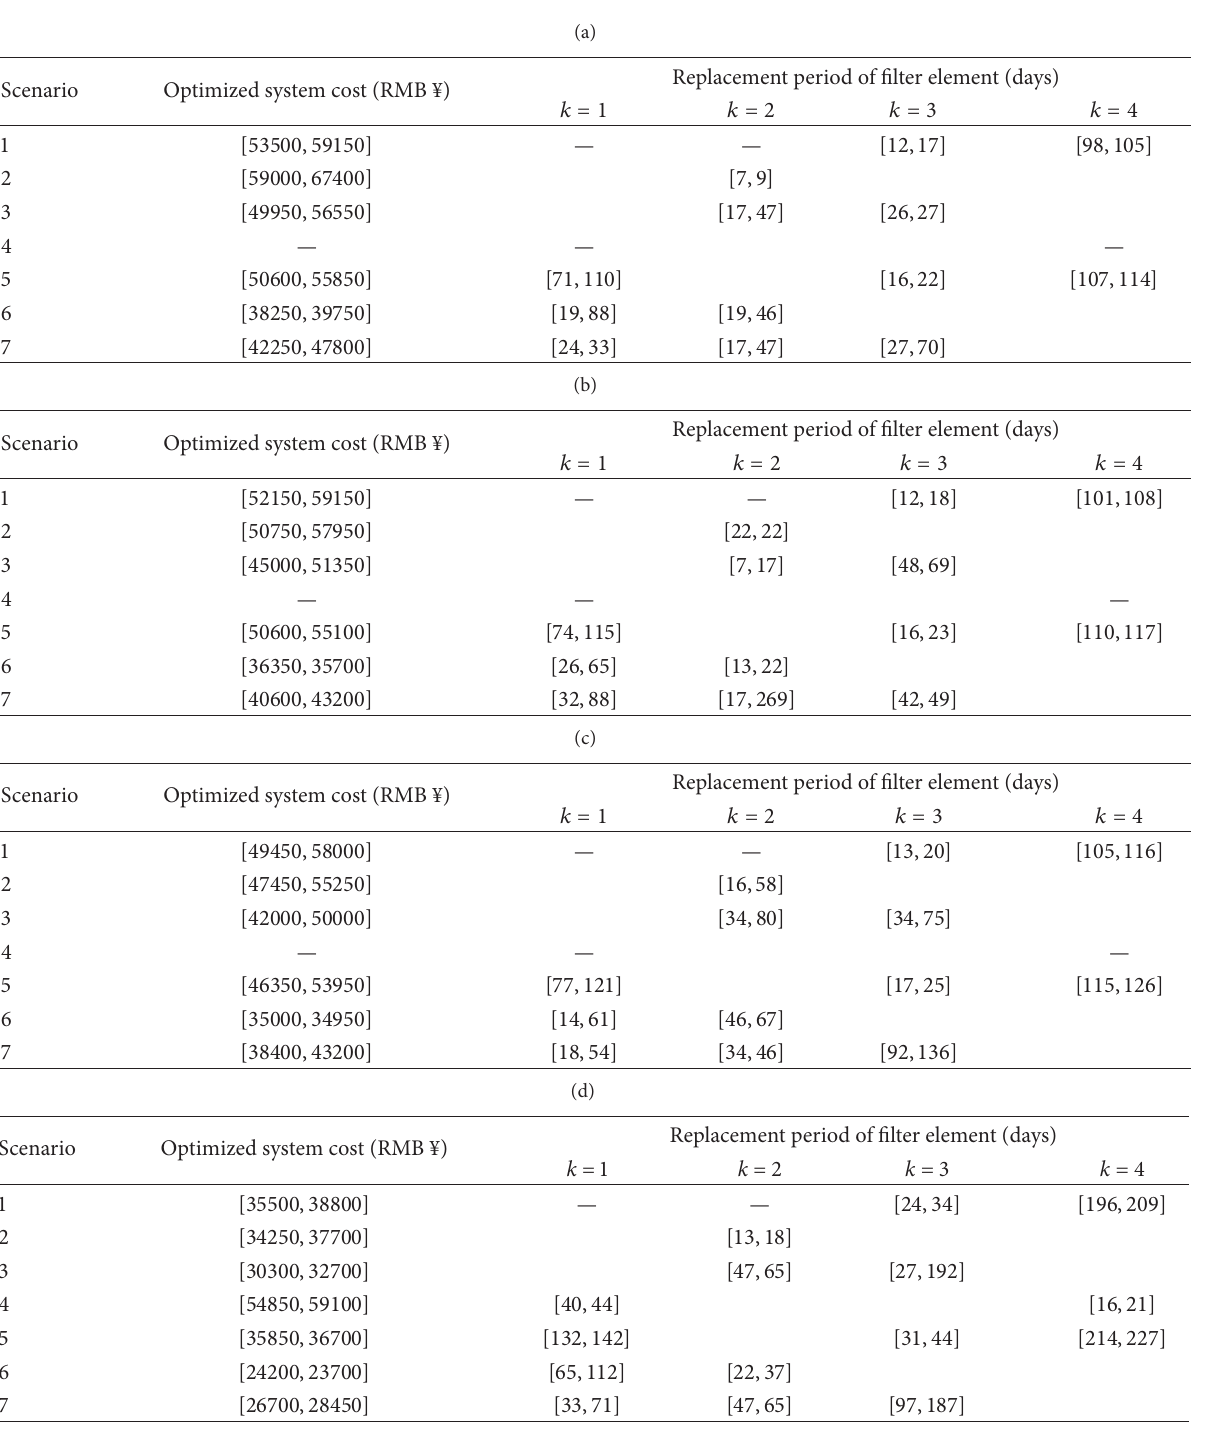
Table 8: (a) Results for optimized system cost and filter-replacement period under high ingression/generation rate (8 hours per day) (when = 0.10 ). (b) Results for optimized system cost and filter-replacement period under high ingression/generation rate (8 hours per day) 𝑝 1 (when 𝑝 2 = 0.15 ). (c) Results for optimized system cost and filter-replacement period under high ingression/generation rate (8 hours per day) (when 𝑝 3 = 0.20 ). (d) Results for optimized system cost and filter-replacement period under high ingression/generation rate (8 hours per day) (when 𝑝 4 = 0.30